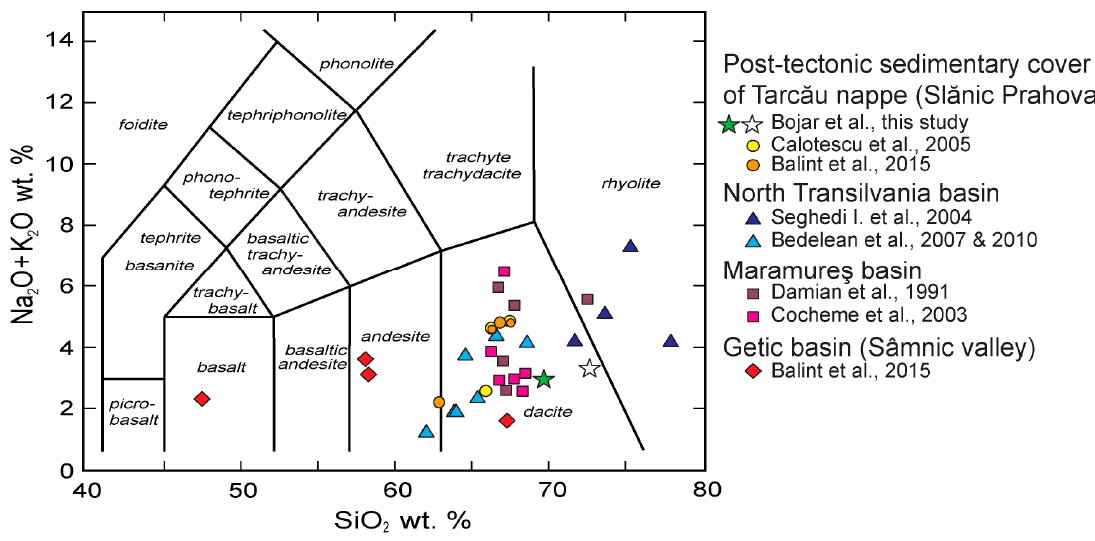
Figure 4. Position in a SiO 2 vs. (Na 2 O + K 2 O) plot of investigated tuff as well as previous published data [4,5,8,14,41–43].